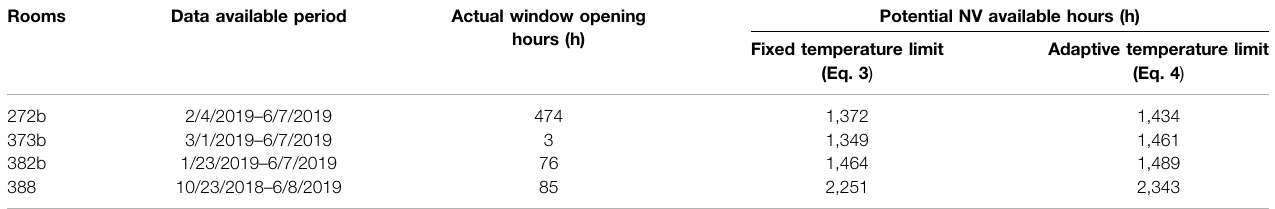
TABLE 2 | Potential NV availability and actual window opening hours in typical rooms a